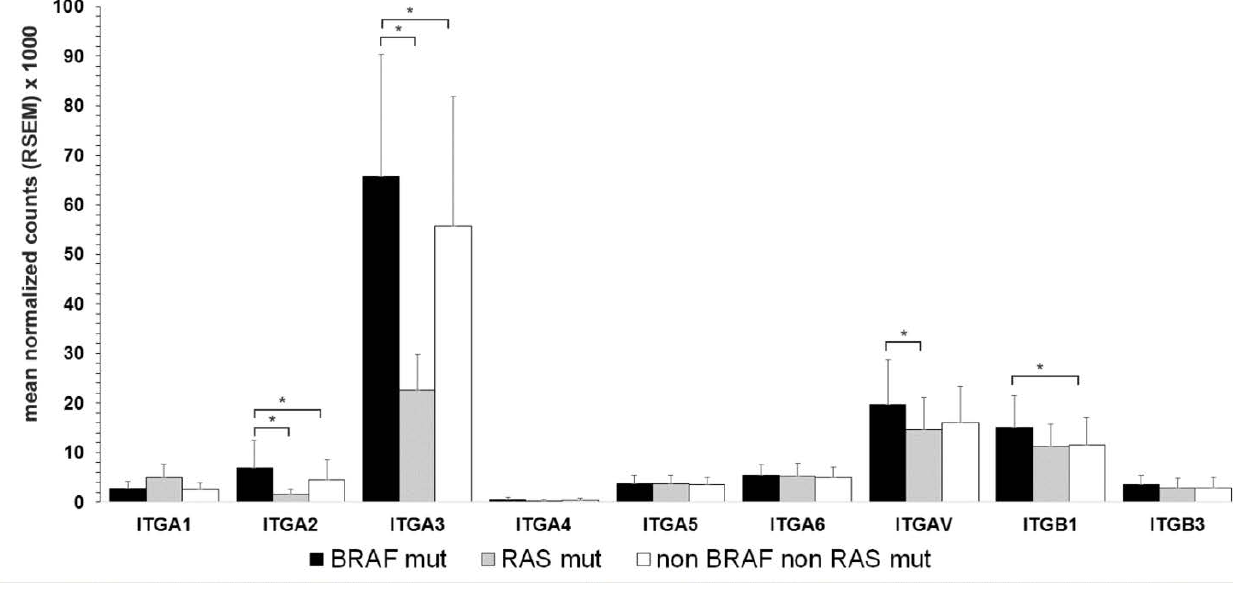
Figure 2. Integrin subunits expression in PTC variants. Mean and standard deviation of mRNA integrin subunits of PTC classical (PTCcl, n = 358), follicular (PTCfv, n = 101), and tall cell variants (PTCtc, n = 37). * Wilcoxon: * p <